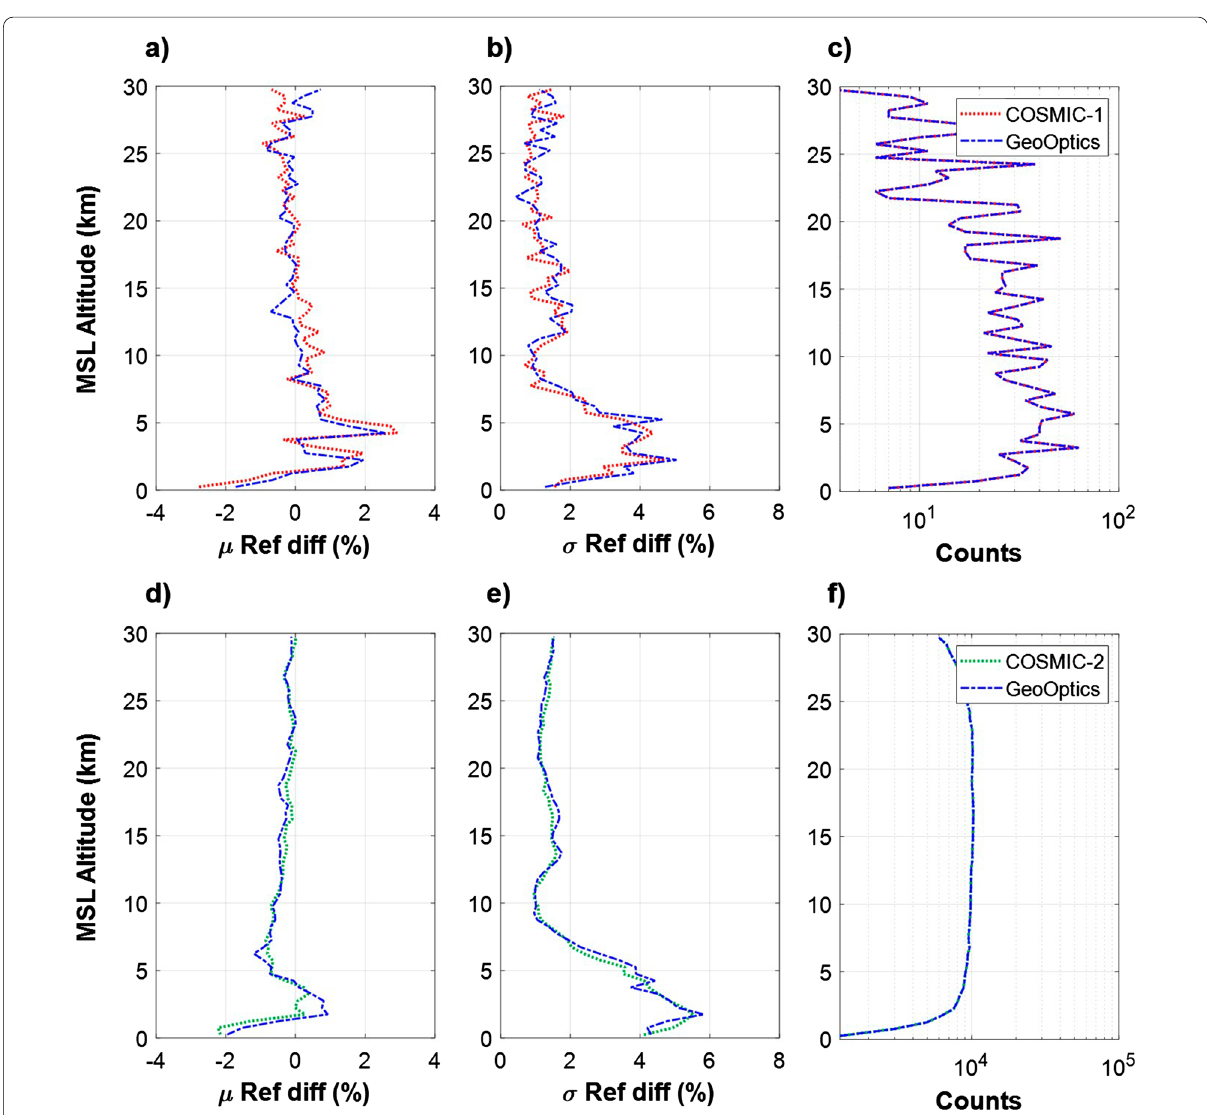
× 100 (cid:30) and c counts of observations from COSMIC-1 radiosonde